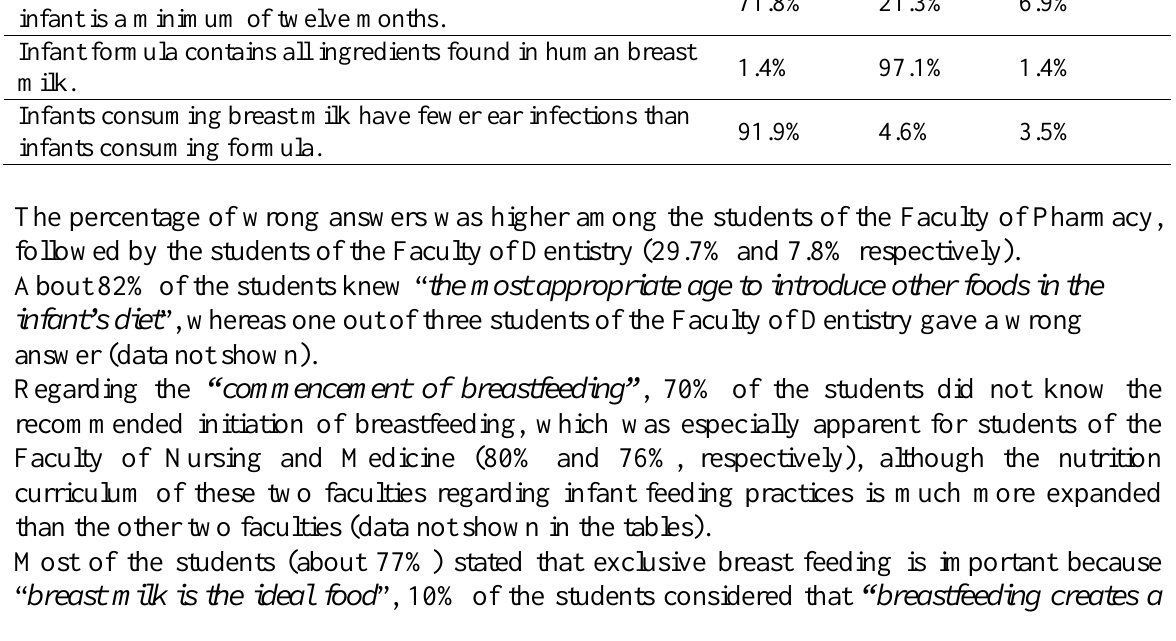
Table 2. Students’ knowledge on infant feeding practices Correct Wrong Don’t